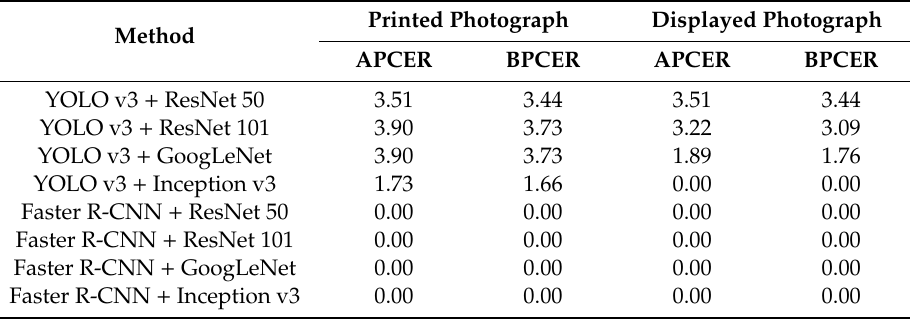
Table 5. Validation results of the head detector as a presentation attack detector 1